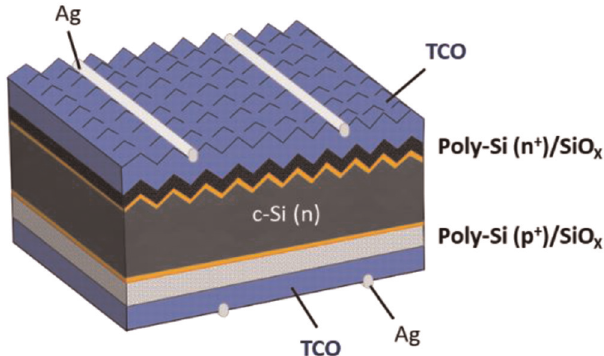
Fig. 1. c-Si solar cell structure in rear emitter con fi guration with double side passivated contacts elaborated by high (poly-Si/SiO x ) temperature route.